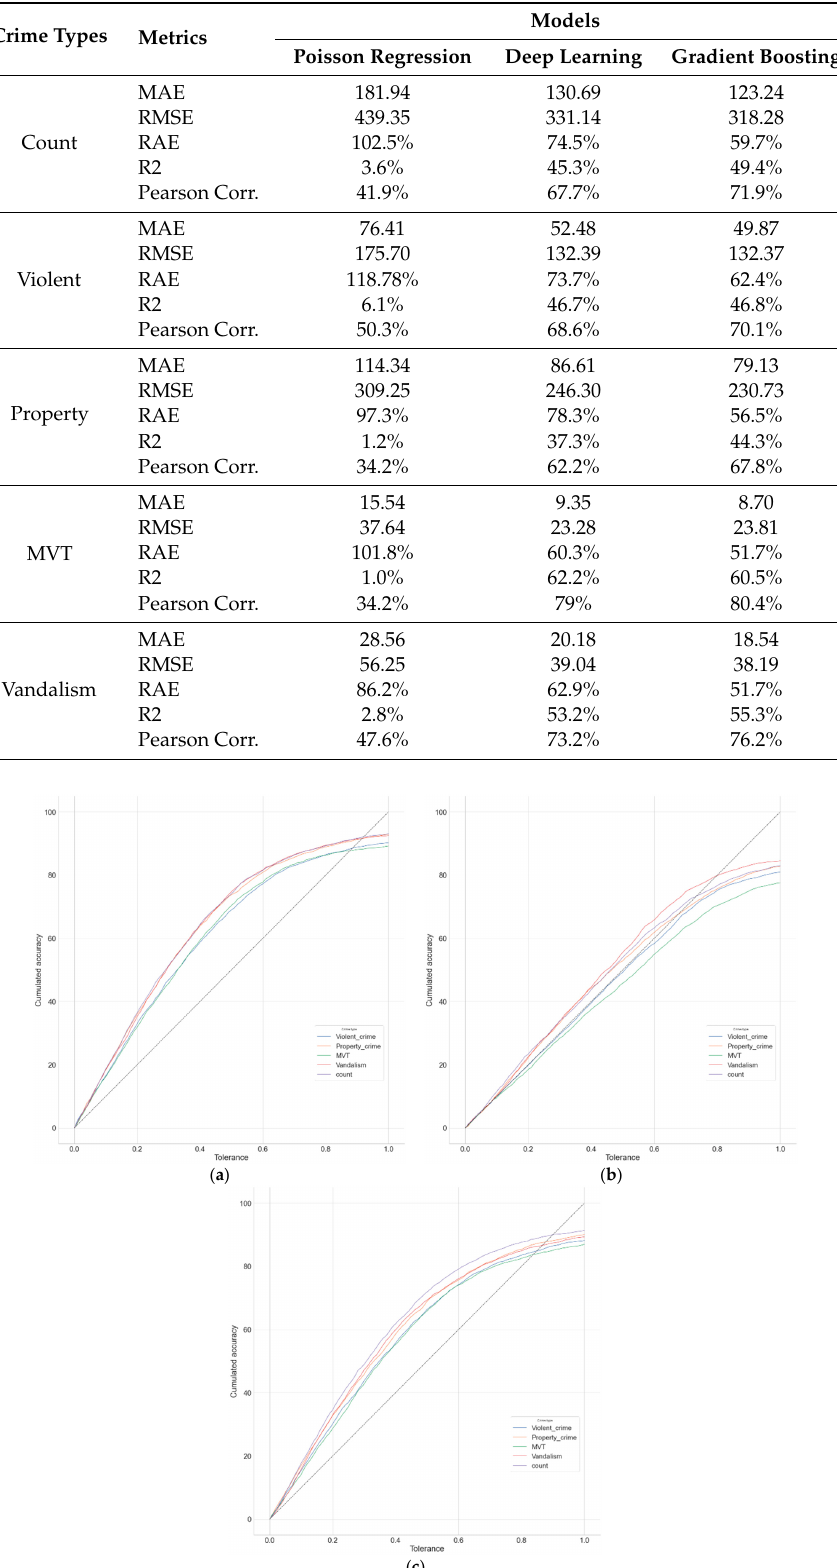
Figure 2. Regression Error Characteristic (REC) curves for ( a ) the gradient boosting model, ( b ) the Poisson model, and ( c ) the deep learning model. The gradient boosting model outperforms the other models in all the evaluated types of crime and across all metrics. It should be noted, however, that the deep learning model also yields performances close to the gradient boosting results. In order to further evaluate the performance of these predictive models, we selected a random set of 1000 observations from the input dataset and then we compared the predicted crime occurrences of each type of crime, in addition to the total count of crime occurrences, against the ground truth, as depicted in Figure 3. On this sample of observations, the gradient boosting and the deep learning models yield competitive results compared to the Poisson regression.